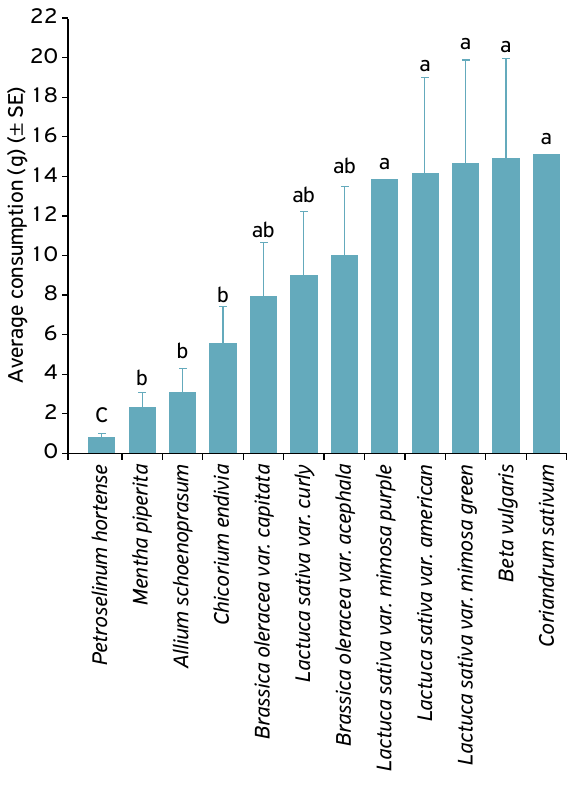
Figure 6. Average number of fresh matter consumed by adult Achatina fulica in food preference test with chance of choice,